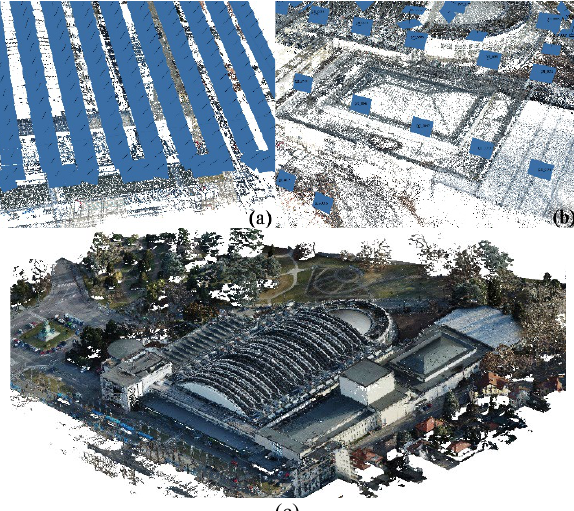
Figure 3 . The photogrammetric project: (a) Example of nadir acquisitions (b) 45° oblique images; (c) the 3D dense cloud.